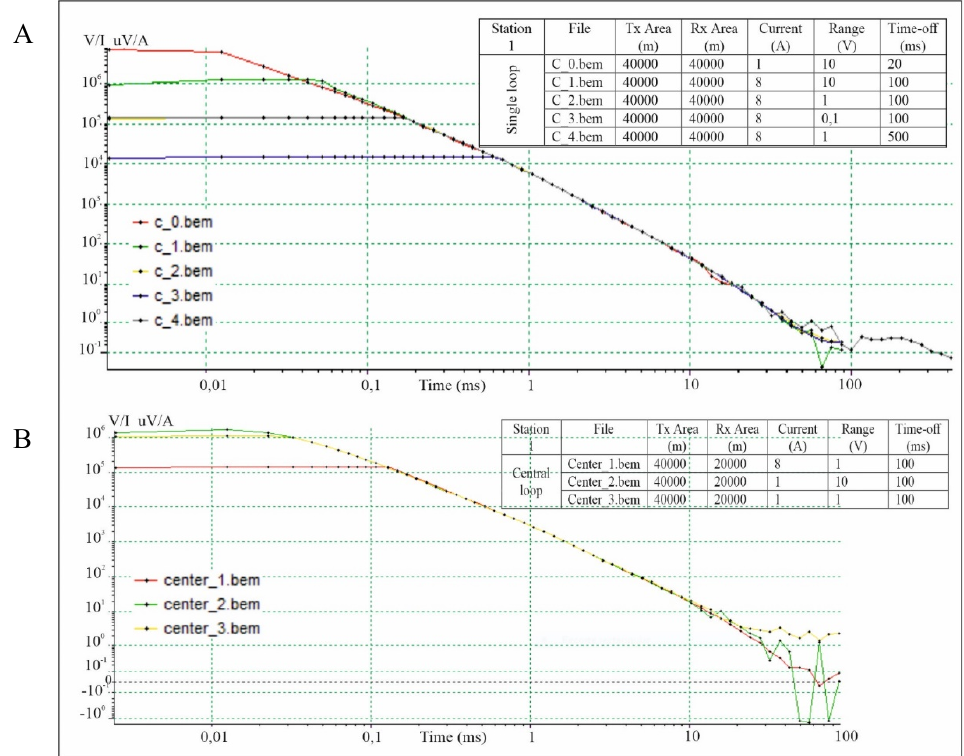
Figure 4. Different induced voltage curves as a function of time, all collected at station S1. Different measurement parameters were used in each of the curves (variations in Current, Voltage, Time). ( A ) The curves represent a single-loop configuration so that the transmitter area (Tx) and the receiver area (Rx) coincide (200 m × 200 m = 40,000 m 2 ). ( B ) The curves represent a central-loop configuration, where the same transmitter loop is maintained, but the receiver loop (Rx) has dimensions of 20 m × 20 m; in this case, a five-wire cable and an amplifier of ×10 were used, so the effective area of Rx in this case is 20 × 20 × 5 × 10 = 20,000 m 2 .